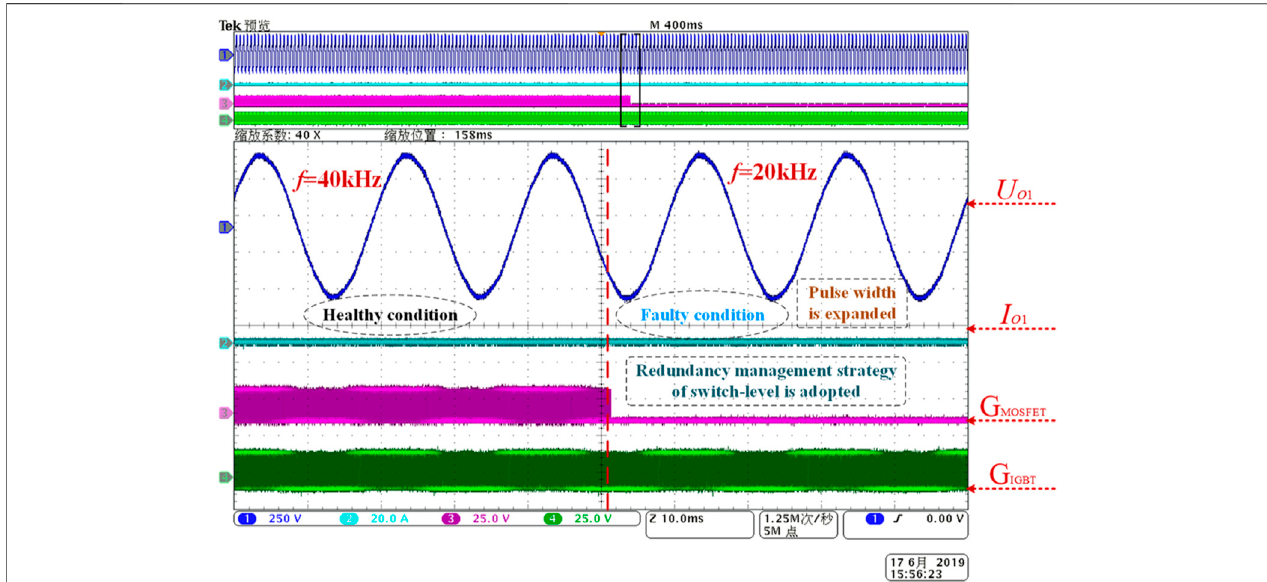
FIGURE 8 | Experimental waveforms (open-circuit fault of MOSFET occurs, I o is smaller than I 1 max ).